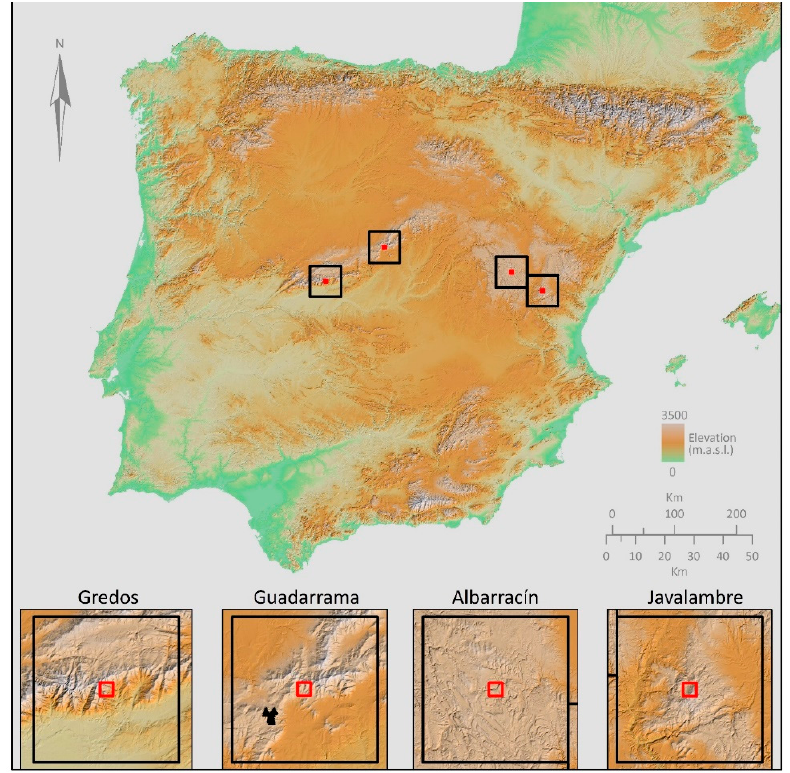
Figure 1. Location of the four mountain regions in the Iberian Peninsula. Black polygons represent 50 × 50 km squares for mesoclimate analysis, centred on red 6 × 6 km squares for microclimate analysis. Guadarrama inset: black triangles show locations of dataloggers for field validation of